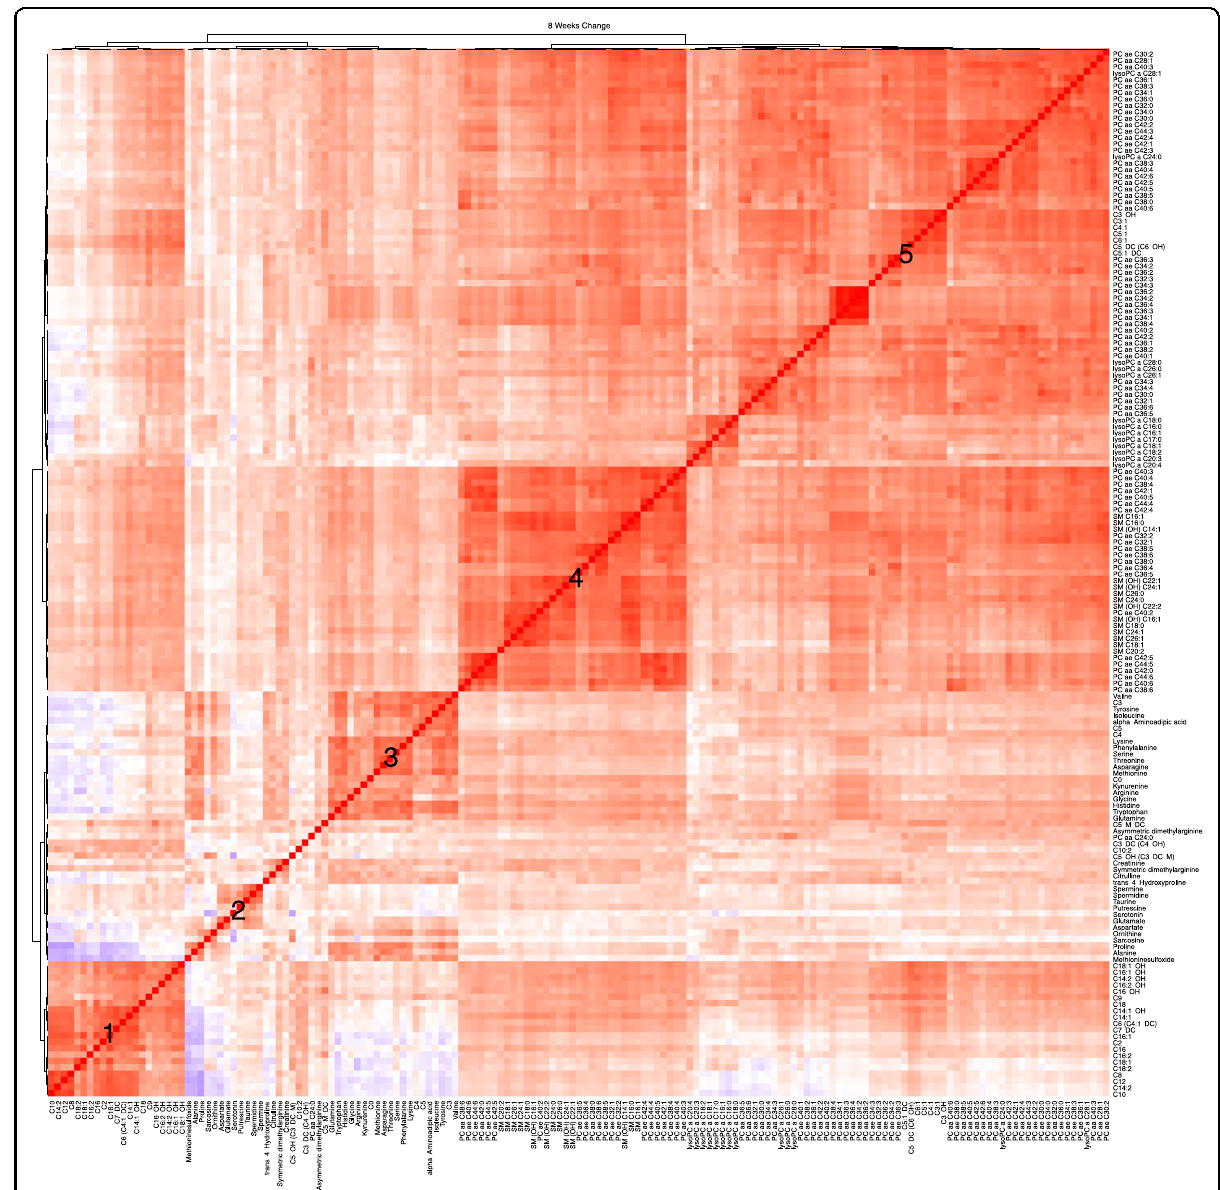
Fig. 3 Hierarchical clustering of Spearman ’ s rank correlation of change in metabolite levels. Red represents positive correlations and blue represents negative correlations. Cluster #1: enriched for medium and long-chain acylcarnitines (e.g., C8, C9, C10, C12, C16), Cluster #2: biogenic amines including serotonin, spermine, spermidine, taurine, putrescine, glutamate, ornithine, and sarcosine. Cluster #3: short-chain – acylcarnitines (C3, C4, C5), branched-chain amino acids (isoleucine and valine), kynurenine, arginine, glycine, tryptophan, and glutamine. Cluster #4: long-chain phosphodelcholine of PC ae class and Cluster #5: a large number of phospholipids and lysophospholipids. PC phosphatidylcholine, LysoPC lysophosphatidylcholine, SM sphingomyelin. Metabolite abbreviations are spelled out in Supplementary Table